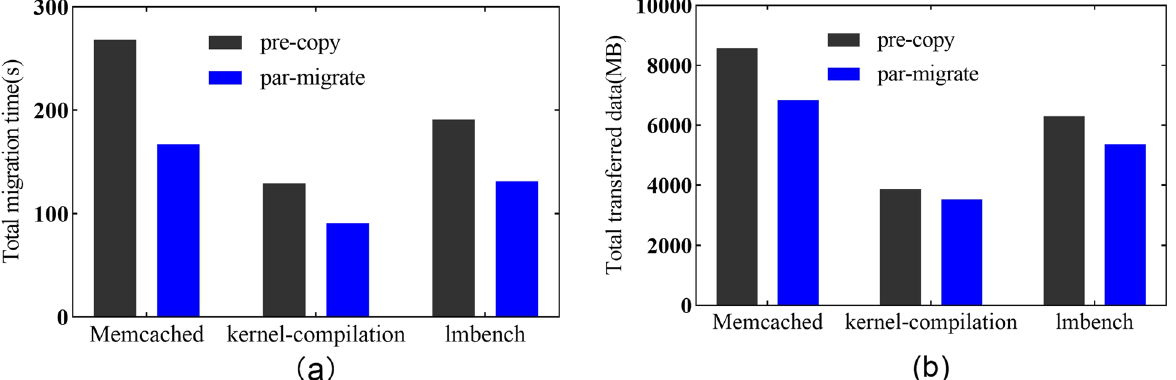
Fig. 5 Performance comparison for different workloads. a Total migration time b Total transferred